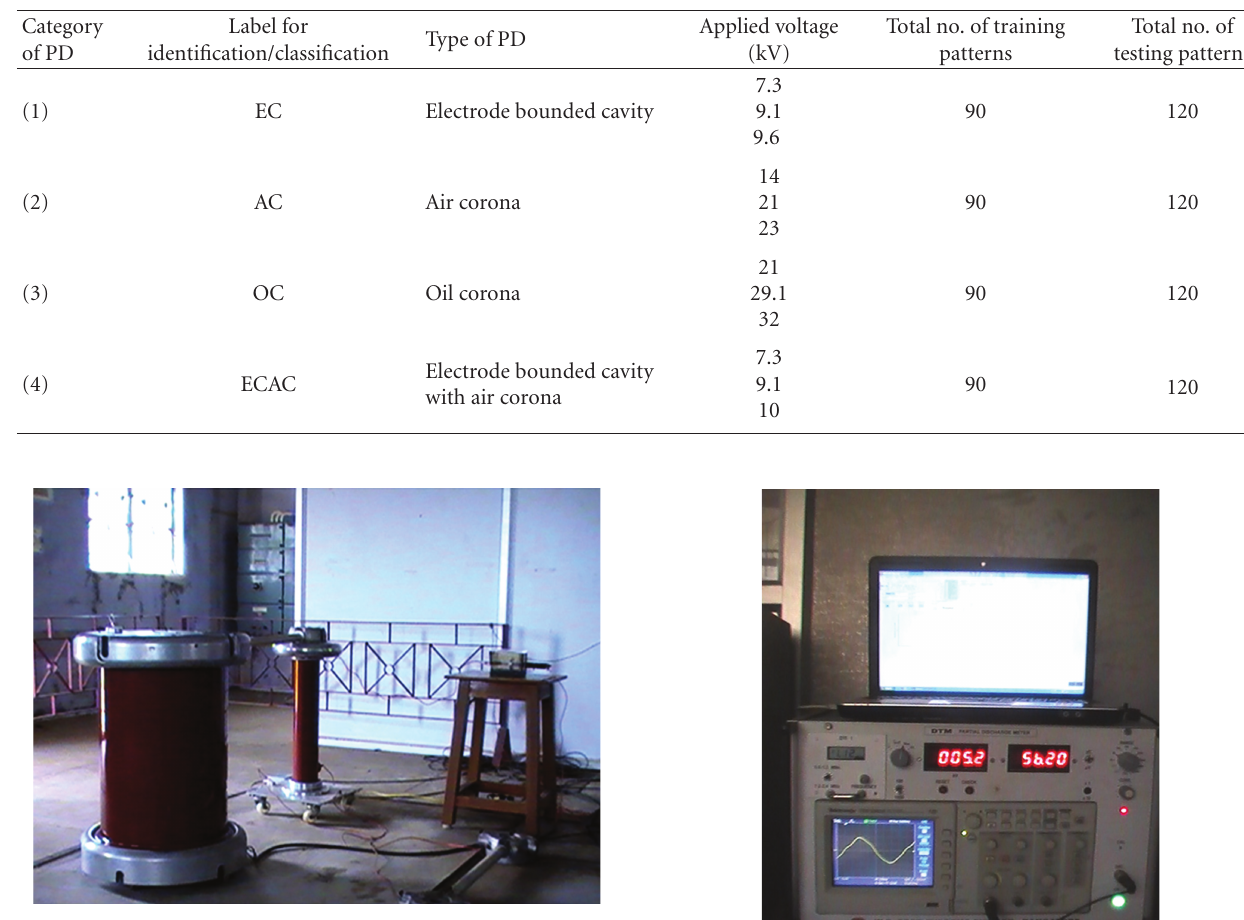
Figure 7: Laboratory experimental test setup indicating the direct detection PD measurement methodology.